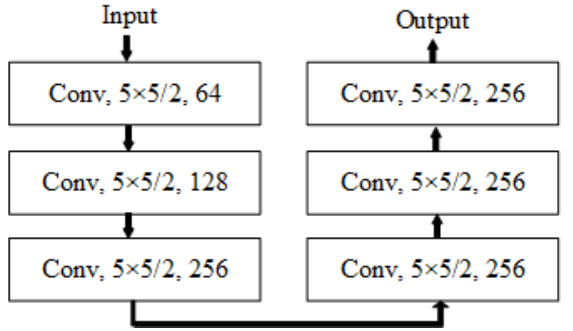
Figure 3. The structure of discriminator in the proposed GAN for interference